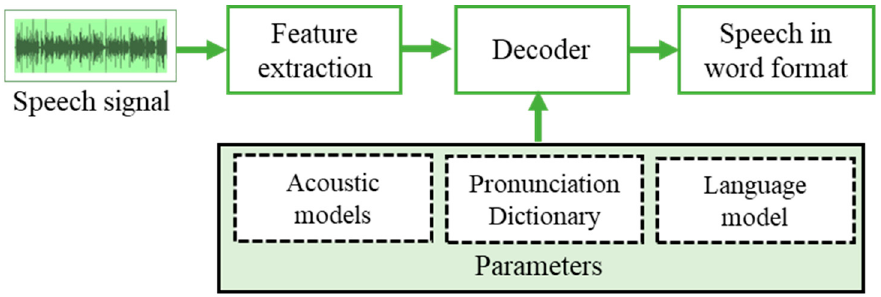
Figure 5. Working model of Hidden Markov Model.